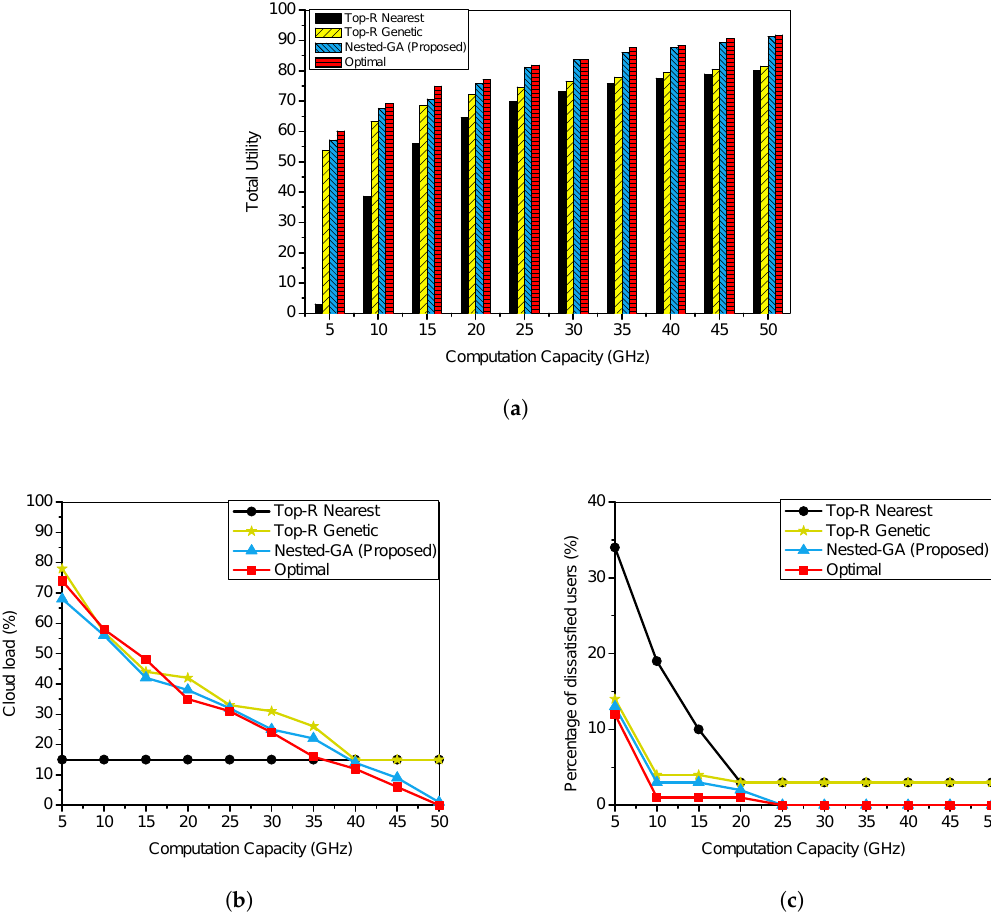
Figure 8. ( a ) Total utility; ( b ) Cloud load; ( c ) Percentage of dissatisfied users versus computation capacity of